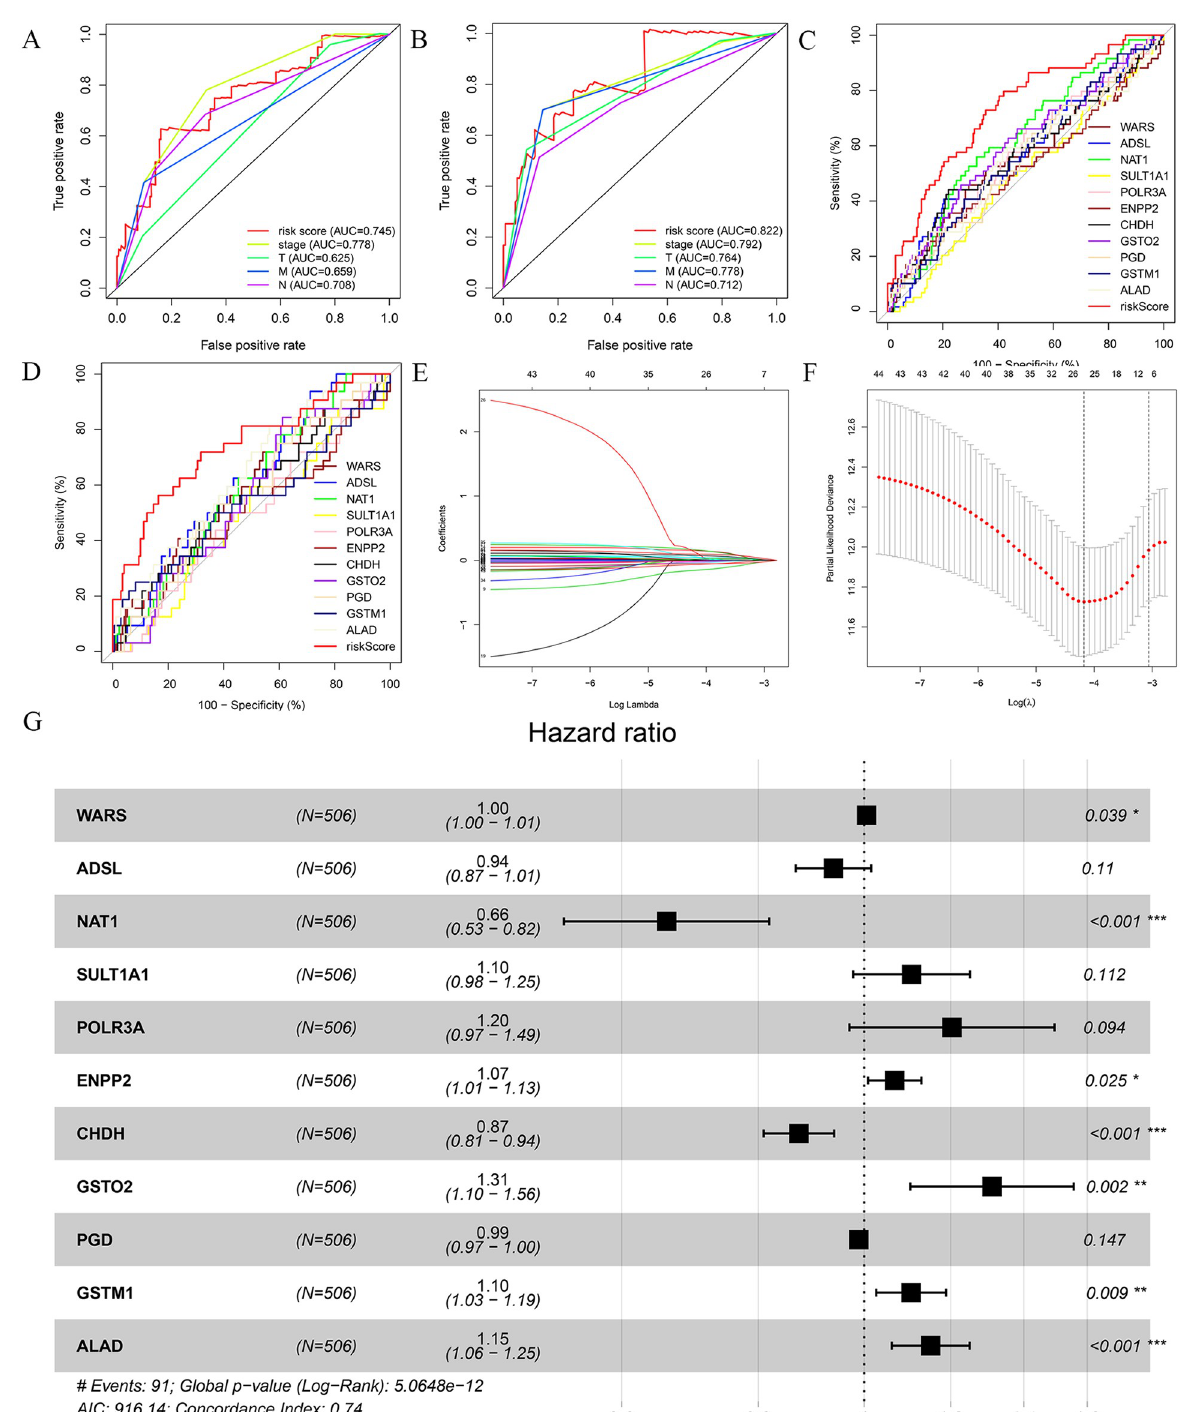
Fig 1. Screening and ROC analysis of the genes used for model construction. The ROC analysis of training and test data from TCGA-train (A and C) and TCGA-test cohort (B and D) showed that the combined multi-gene prognostic model is more accurate than clinicopathological (A and B) and single-gene (C and D). Lasso regression analysis (E and F), 25 genes were selected. “Log Lambda” represents the minimal cross-validation error. Multivariate Cox analysis (G) screened 11 genes for the construction of the prognostic model.